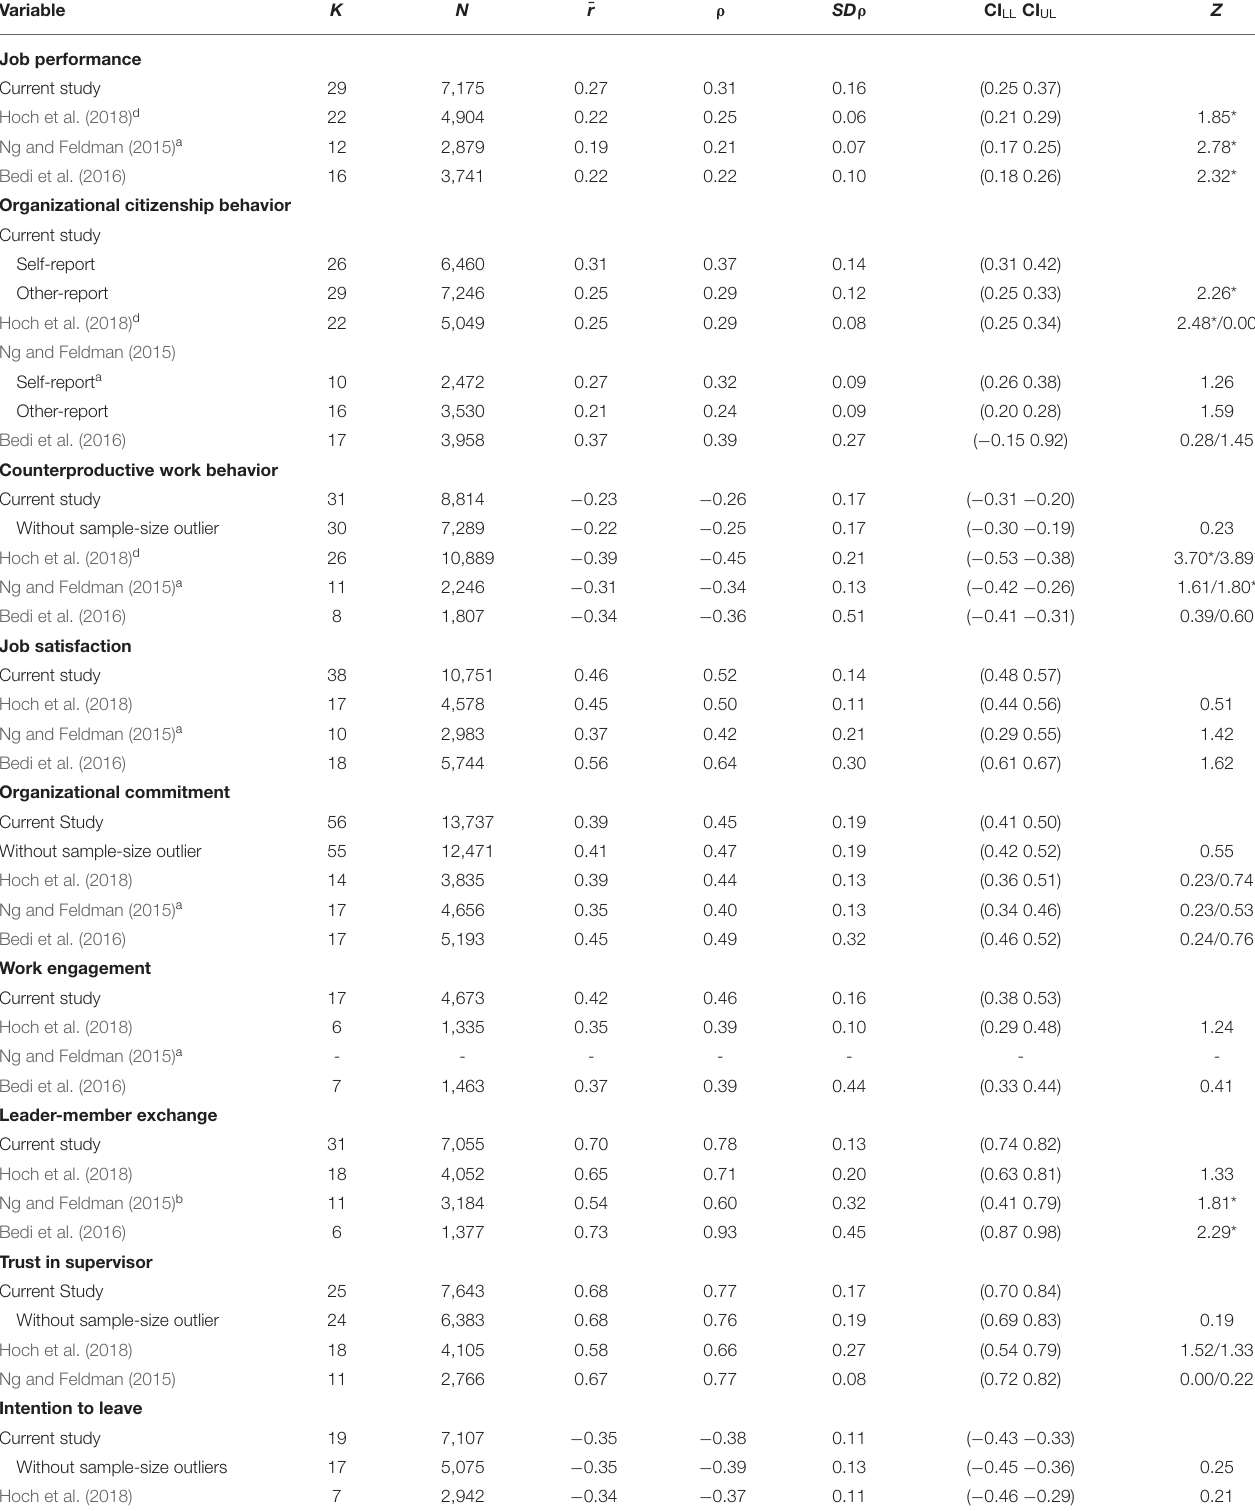
TABLE 2 | Comparison of current and prior meta-analytic results for ethical leadership.